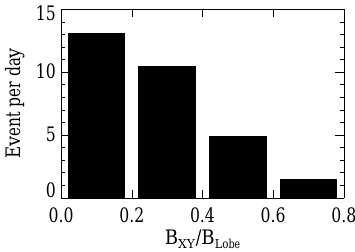
Figure 7. Histogram of the occurrence rate of the DFs along the neutral sheet